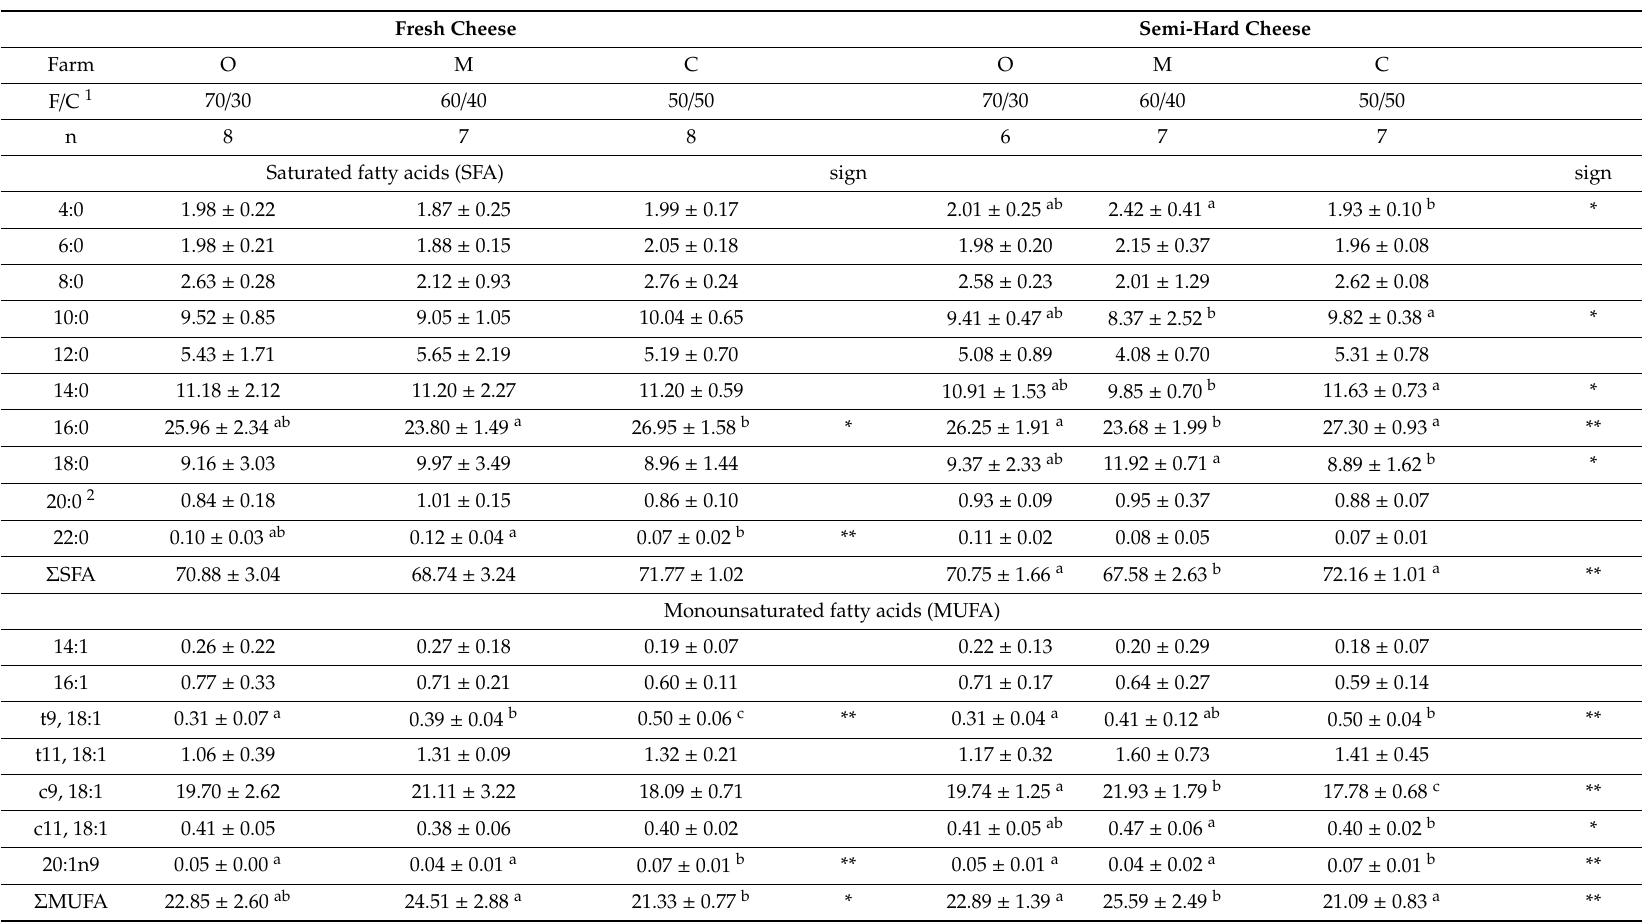
Table 1. Fatty acids composition of fresh and semi-hard goat cheese samples. Data are expressed as g / 100 g of total fatty acids (mean ± standard deviation). Fresh Cheese Semi-Hard